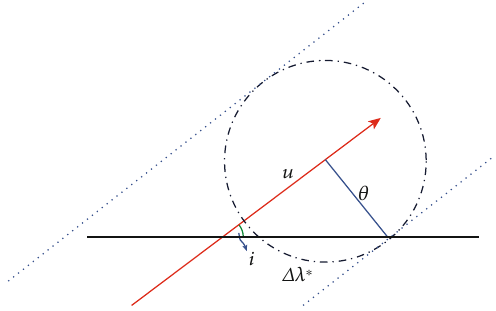
Figure 7: The facade of circle coverage on the equator.